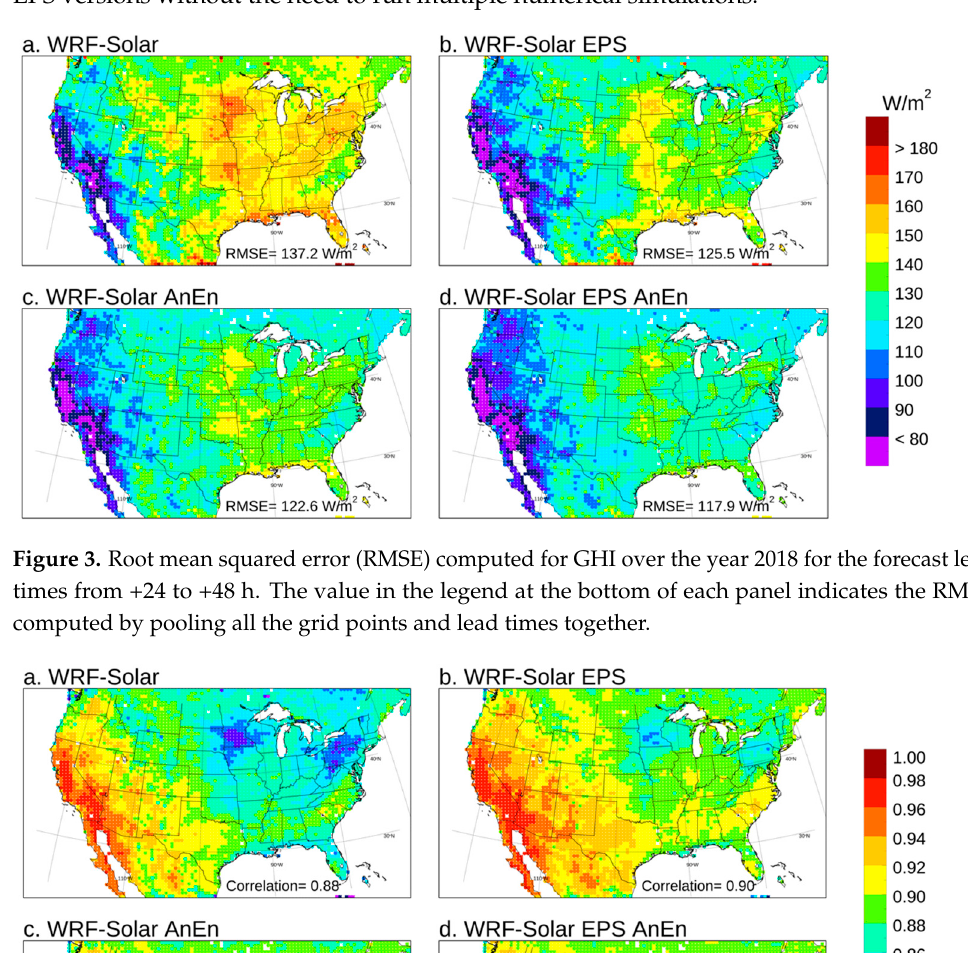
Figure 2. Bias computed for GHI over 2018 for the forecast lead times from +24 to +48 h. The value in the legend at the bottom of each panel indicates the bias computed by pooling all the grid points and lead times together.